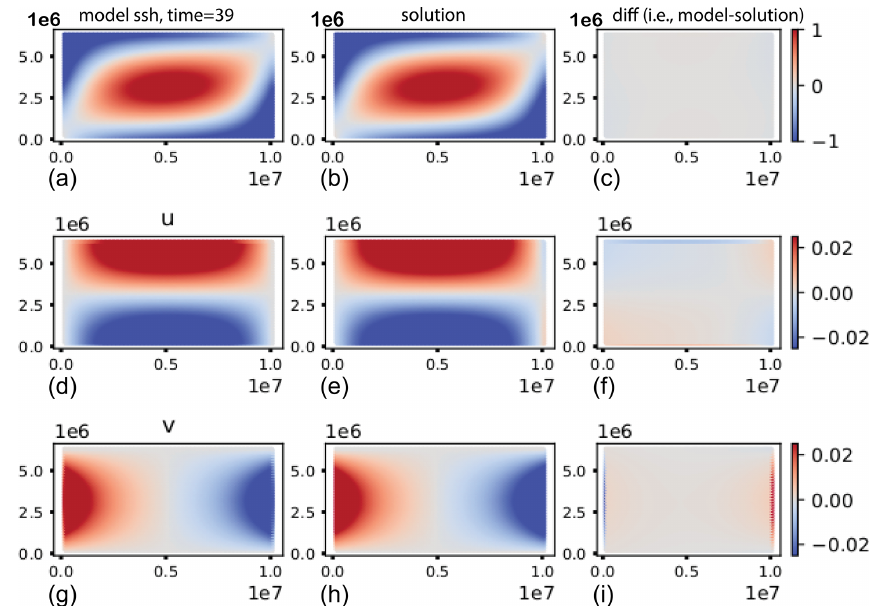
Figure 2. Comparison of MPAS-Ocean results against theoretical predictions by Stommel (1948) for the f plane case: simulation (a, d, g) ; analytical solutions (b, e, h) and their difference (c, f, i) for the sea surface height (m), zonal velocity u and meridional velocity v (ms − 1 ). Comparisons were made at 39d, after the model reached an equilibrium solution. Horizontal axes are x and y